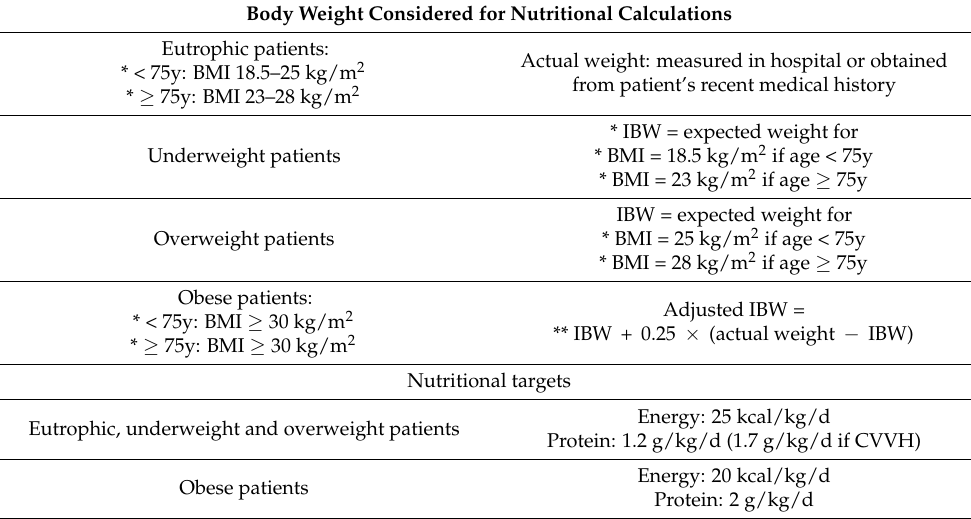
Table 1. Nutrition calculations. y: years; * BMI: body mass index; CVVH: continuous veno-venous hemofiltration; ** IBW: ideal body